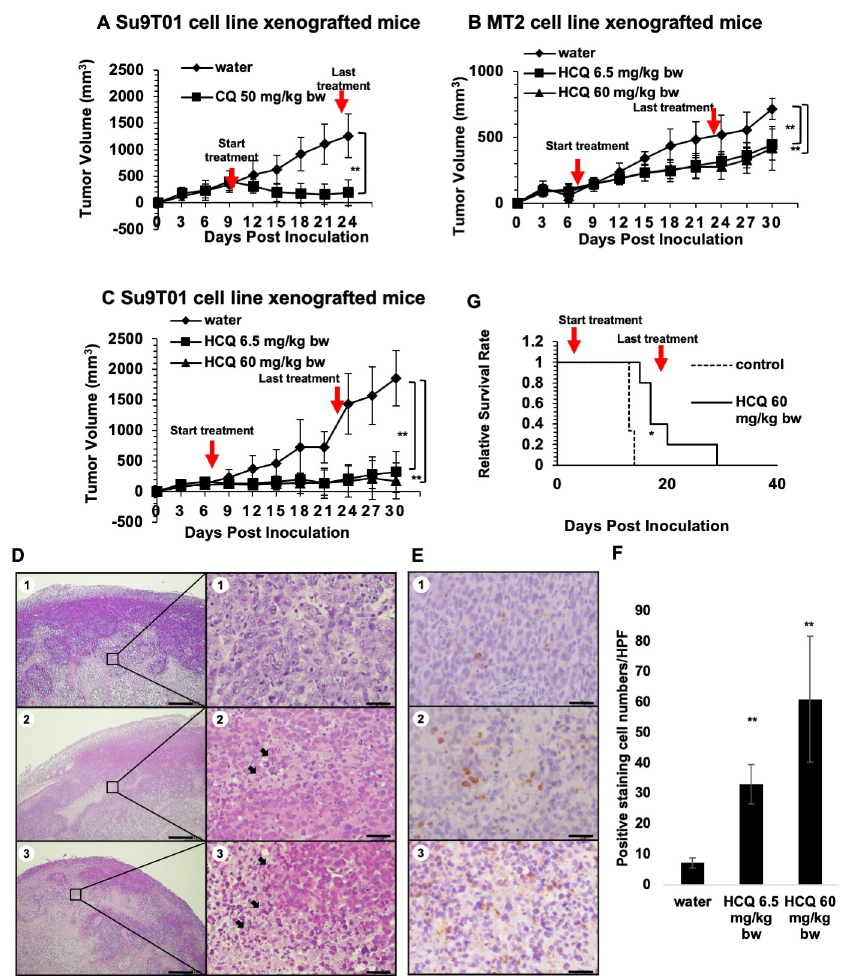
Fig 3. CQ/HCQ inhibited tumor growth and extended the lifespan of ATLL cells-xenografted mice. ( A ) Tumor volume of Su9T01 xenograft tumors in NOG mice intraperitoneally administered water (control) or 50 mg/kg bw CQ daily for 16 days. ( B, C ) Tumor volume of MT2 ( B ) or Su9T01 ( C ) xenograft tumors in NOG mice orally administered water (control), 6.5 mg/kg bw HCQ, or 60 mg/kg bw HCQ daily for 16 days. ( D, E ) Representative H&E ( D ) and IHC images of Caspase-3 ( E ) in tumor tissues from NOG mice orally administered water ( 1 ), 6.5 mg/kg bw HCQ ( 2 ), or 60 mg/kg bw HCQ ( 3 ) daily for 16 days. Scale bars: 300 μ m (D) , 30 μ m ( E ). Higher magnification images of the boxed areas are shown on the right (Scale bars: 30 μ m). The arrows indicate dead tumor cells. ( F ) Quantification Caspase3 stained cells is presented as the mean ± SD (n = 10 HPF, representative image was shown at Fig 3E). (G) Kaplan-Meier survival curves of the intravenous Su9T01 leukemia model orally treated with HCQ or water daily for 16 days. � p < 0.05, �� p < 0.01 compared to the control.